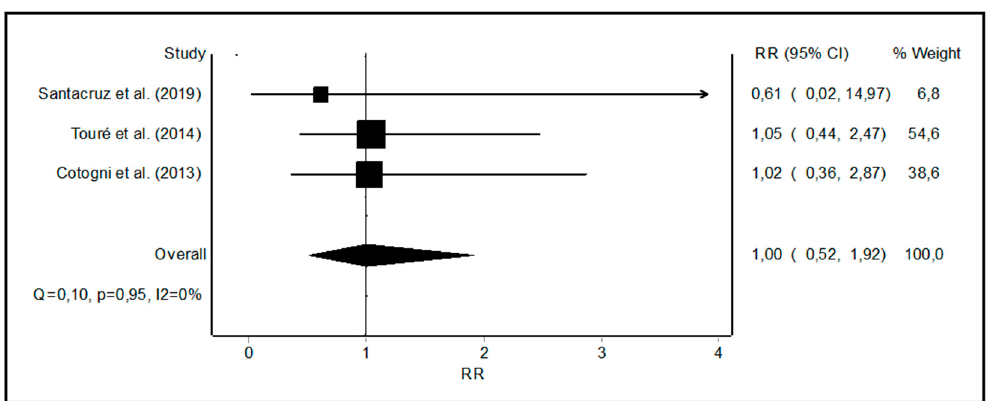
Figure 5. Forest plot showing the relative risk (RR) of catheter-related mechanical complications with peripherally inserted central catheters (PICCs) vs. tunneled central catheters. I 2 , a measure of heterogeneity.